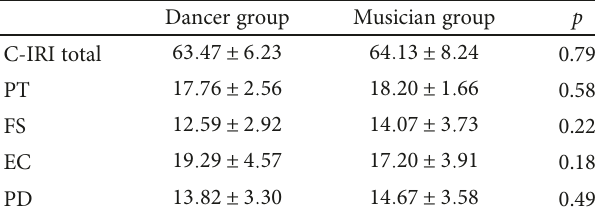
Table 2: Scores of C-IRI in dancer and musician groups. Dancer